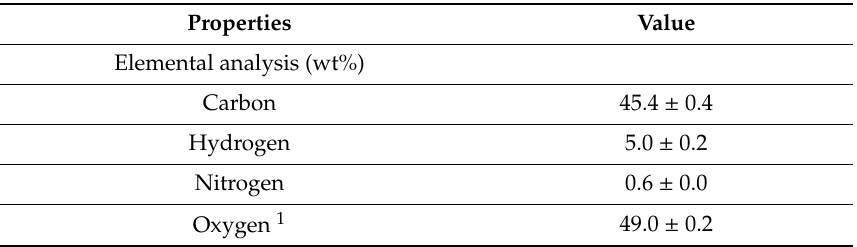
Table 1. Chemical and thermal characteristics of empty fruit